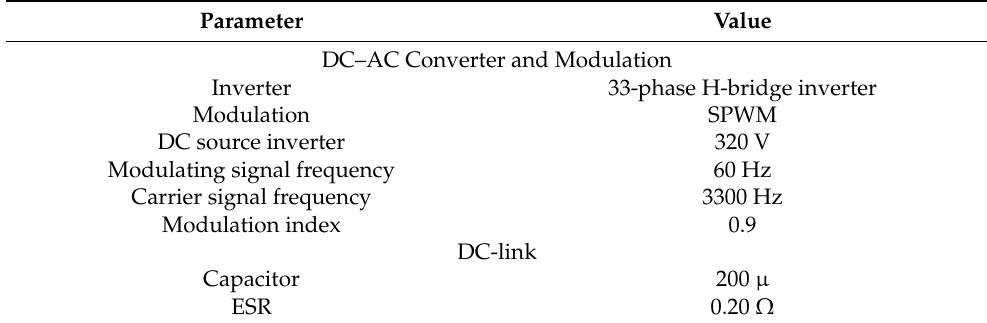
Table 2. Design speci fi cations used for the analysis.